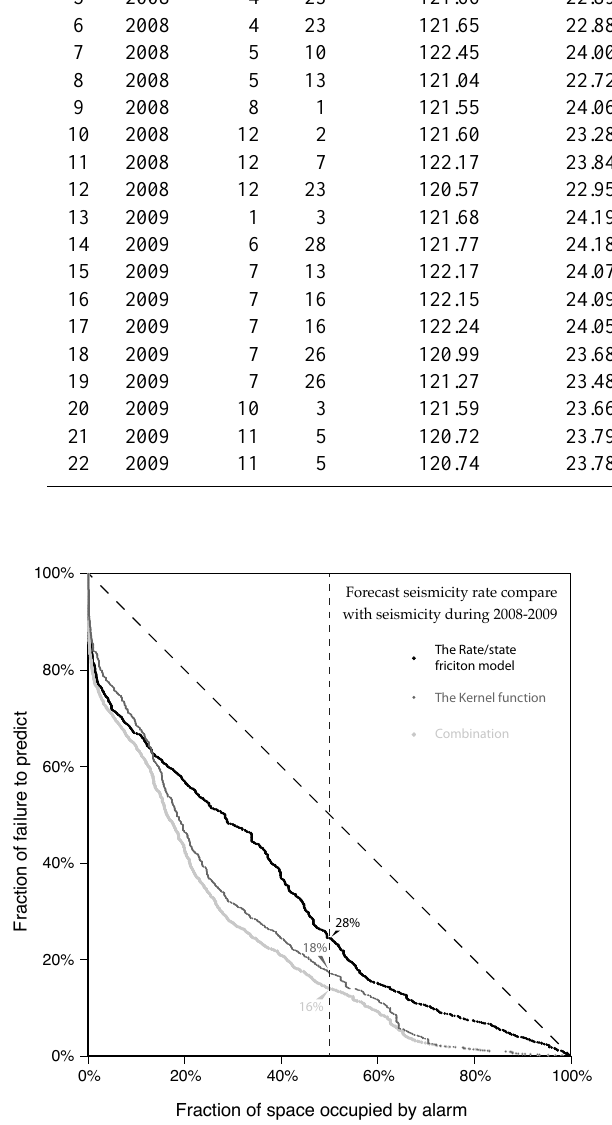
Fig. 4. The Molchan diagram for investigating the correlation be- tween different forecasting models and target earthquakes. The dashed line denotes half of the fraction of space occupied by the alarm, and the corresponding fraction by the failure to predict using each model